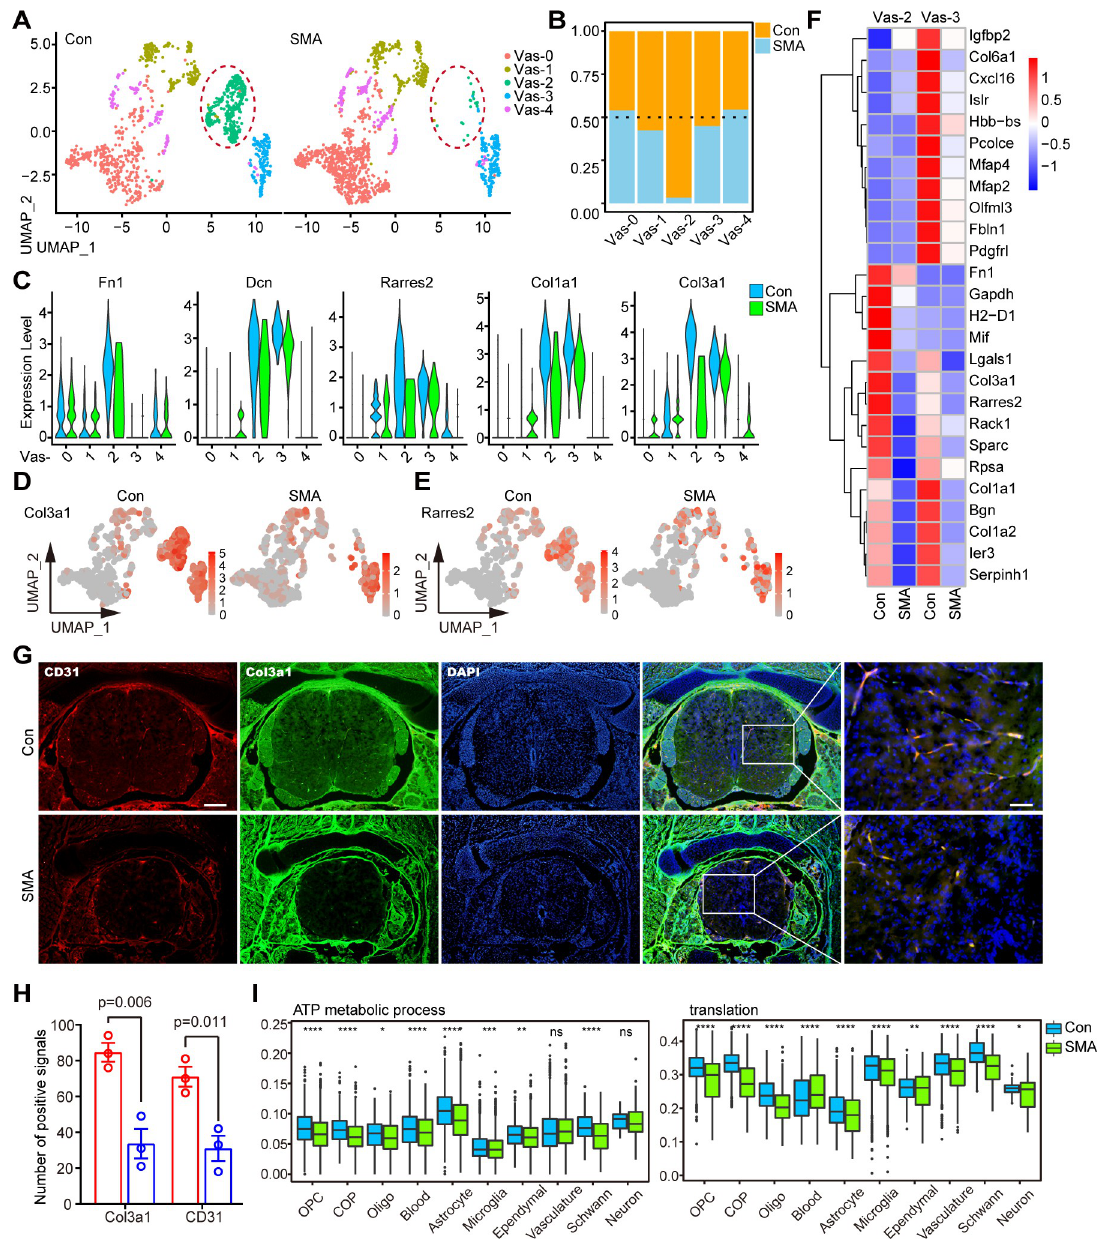
Fig 6. Subpopulation of perivascular fibroblasts was drastically reduced in SMA spinal cord. (A) UMAP visualization showing the subtypes of vasculature in control and SMA mice. Vas-2 is marked by red circles. (B) Comparison of the cell numbers of various subtypes in the vasculature of SMA and control mice. (C) Violin plots showing the expression of fibroblast marker genes in vasculature subtypes. (D, E) UMAP visualization showing the expression of Col3a1 and Rarres2 in the vasculature of SMA and control mice. (F) Expression analysis of the top 13 most significant DEGs in two fibroblast subtypes, Vas-2 and Vas-3. (G) Immunofluorescence staining of spinal cord transections in SMA and control mice. Here, 4’,6-diamidino-2-phenylindole (DAPI)-labeled nuclei are indicated in blue, Col3a1-labeled fibroblasts are indicated in green, and CD31-labeled vascular endothelial cells are indicated in red. Bar = 200 μ m (left) and 50 μ m (right). (H) Statistical results of staining for CD31 and Col3a1. The P-value is calculated by Student’s t-test, n = 3, bars represent the mean with SEM. (I) Expression analysis of protein synthesis (translation) and energy metabolism (ATP metabolic process) pathways of various cell types in SMA and control mice. p-values were calculated through the t-test, ns: p > 0.05, � : p < 0.05, �� : p < 0.01, ��� : p < 0.001, ���� : p <